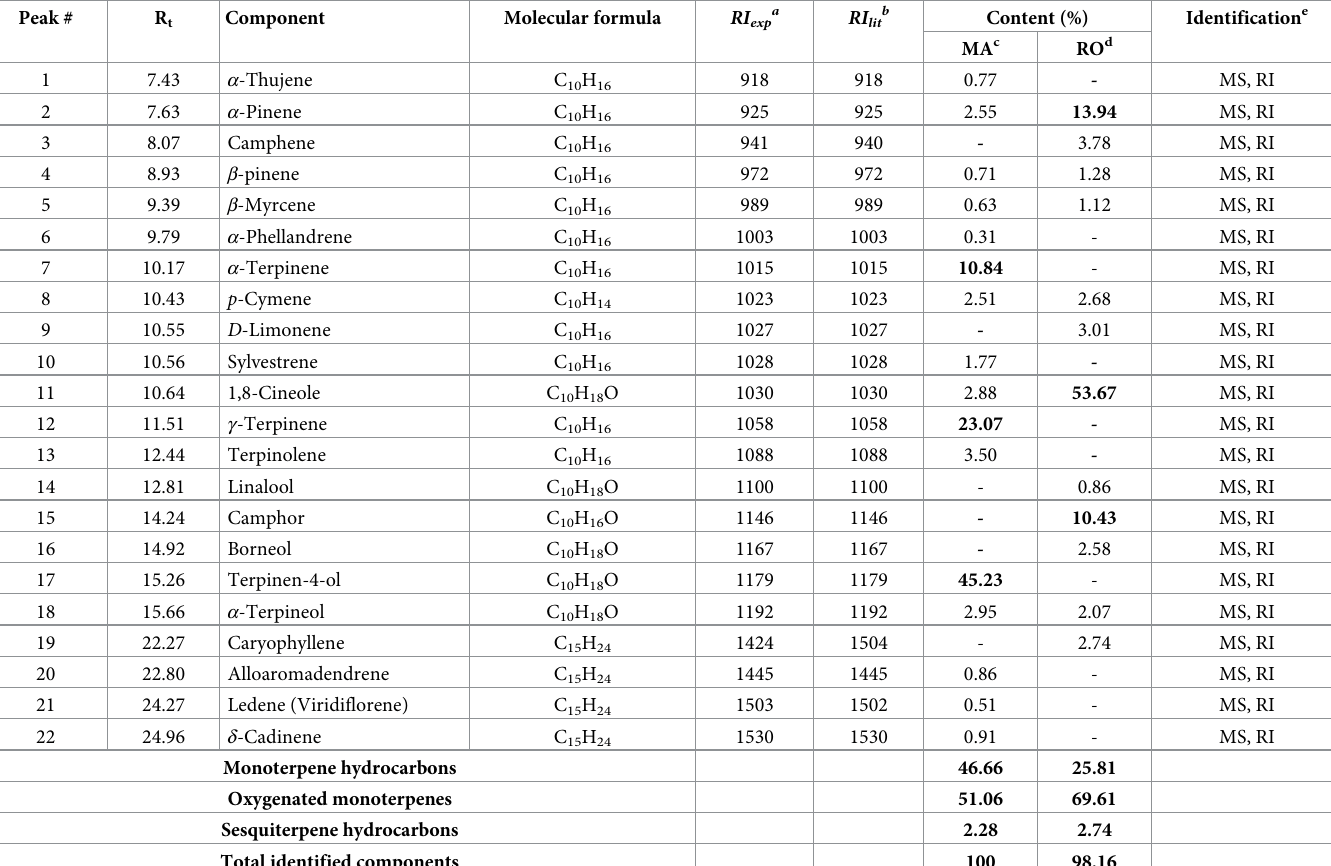
Table 1. Chemical composition of the essential oils of M . alternifolia and R . officinalis .